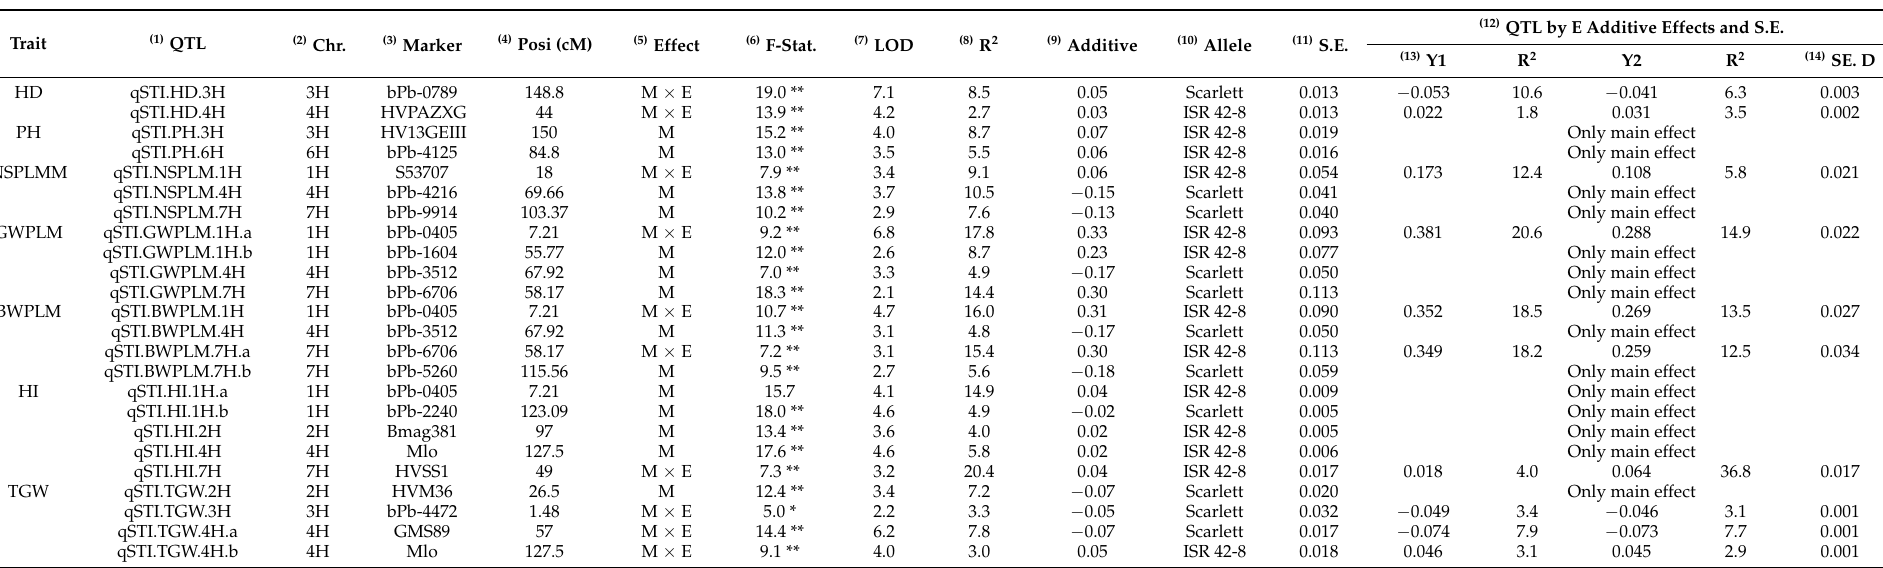
Table 5. Characterization of detected QTL as marker main- and/or by environments additive effects for salinity tolerance index of all measured